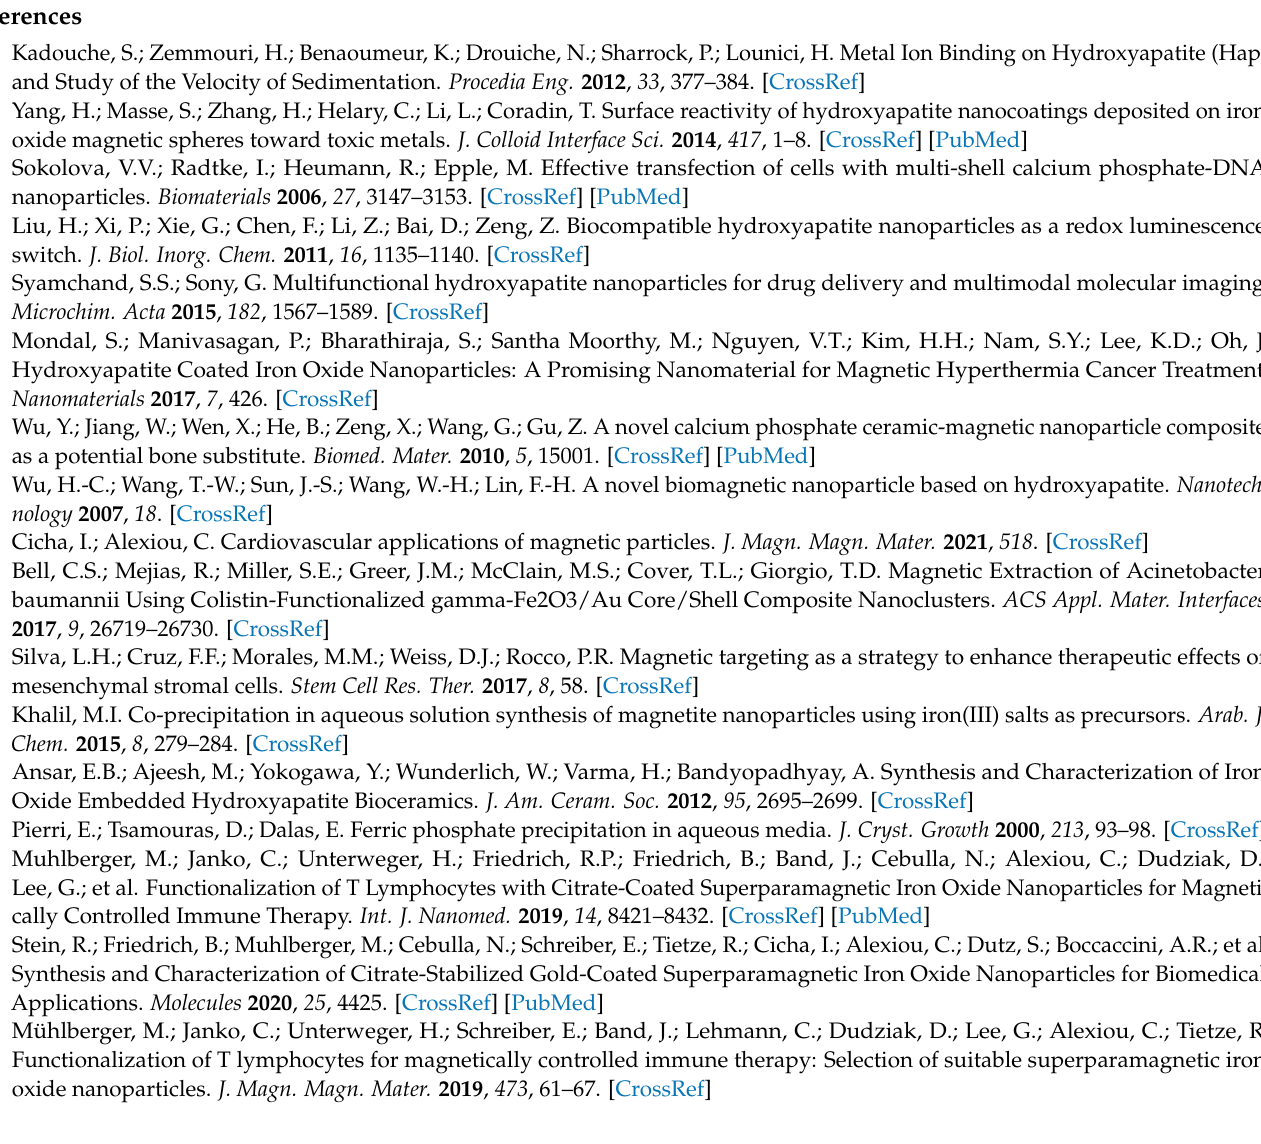
Figure A7. Effects of SPION HAp on side scatter after 24 h of incubation on ( a ) El4 cells (ATCC ® TIB-39™) and ( b ) THP-1 (ATCC ® TIB-202™).